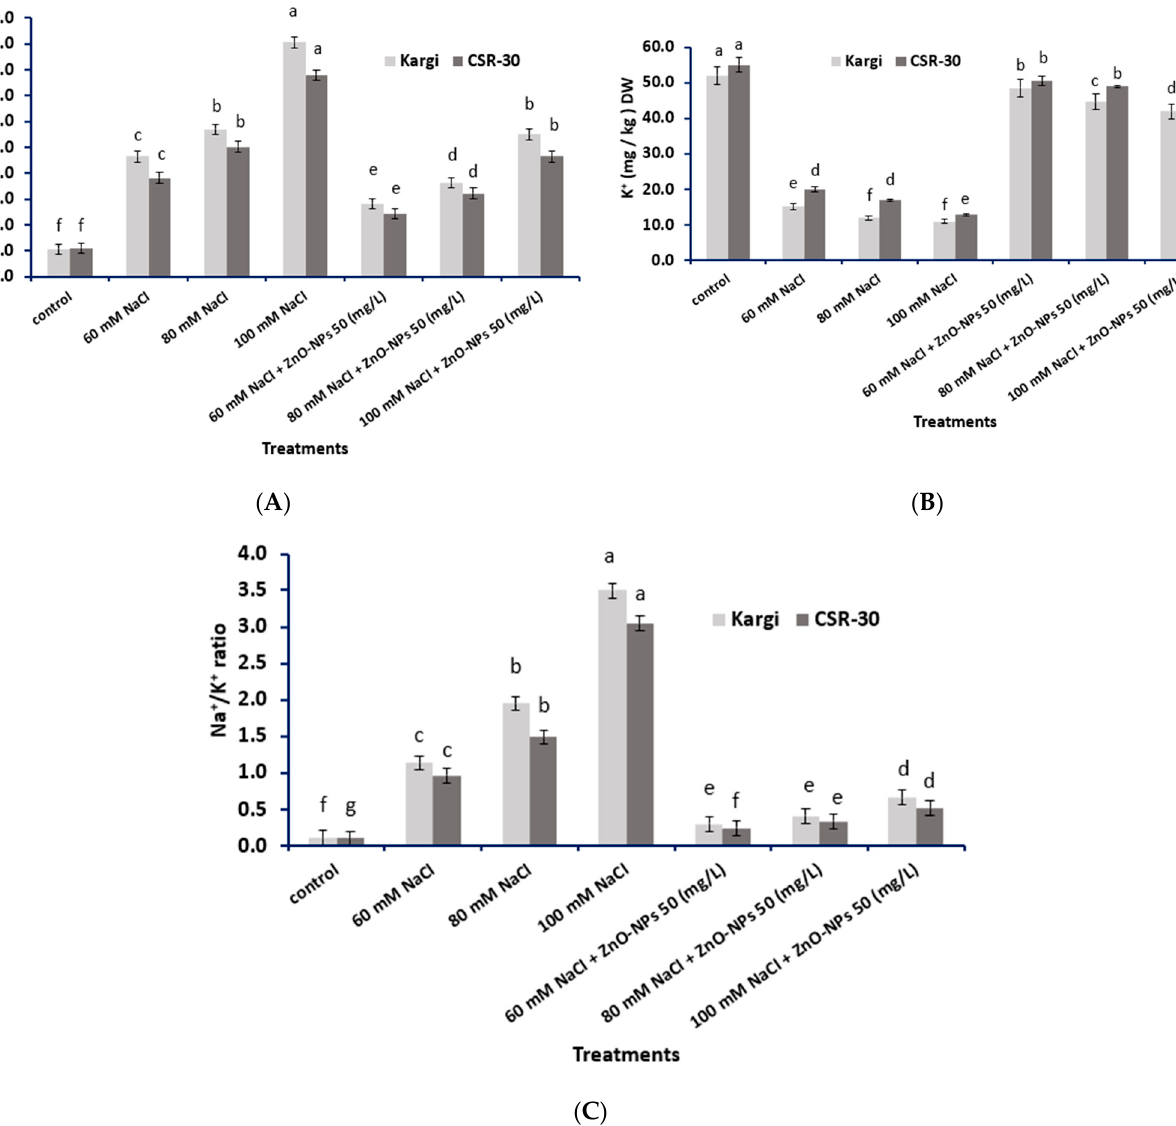
Figure 1. Impact of ZnO-NPs on ( A ) Na + ( B ) K + and ( C ) Na + /K + ratio concentration in leaves of Kargi and CSR 30 Oryza sativa genotype in control and saline conditions. Different small alphabets (a–g) indicate a statistically significant difference between treatments concerning control. Values are means of three replicates. Error bars indicate the least considerable value (LSD) at p ≤ 0.01 among the treatments.